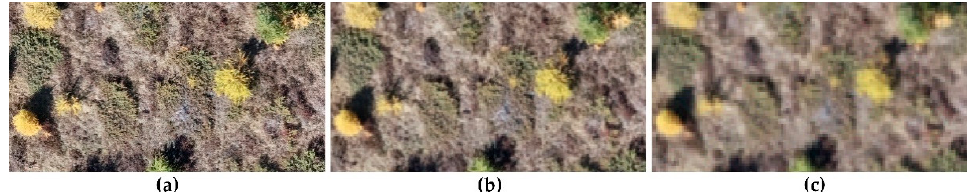
Figure 4. Same portion of the study area at different spatial resolutions: 1 cm ( a ), 5 cm ( b ) and 20 cm ( c ); the original image ( a ) was acquired by drone in October 2018, and it was then resized to obtain two more resolution levels.